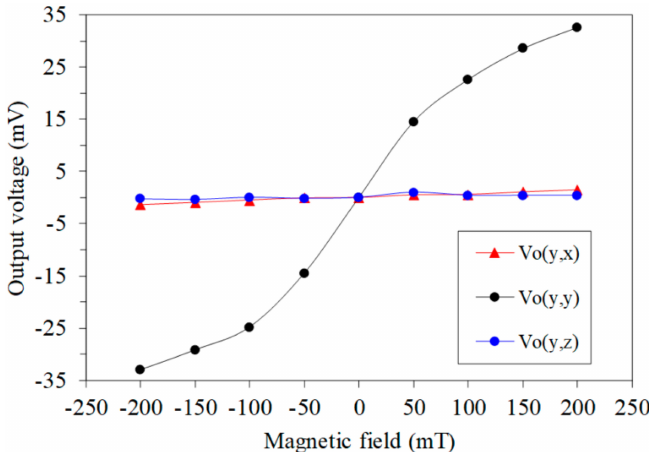
Figure 12. Output of the MMS in the y -axis magnetic field.